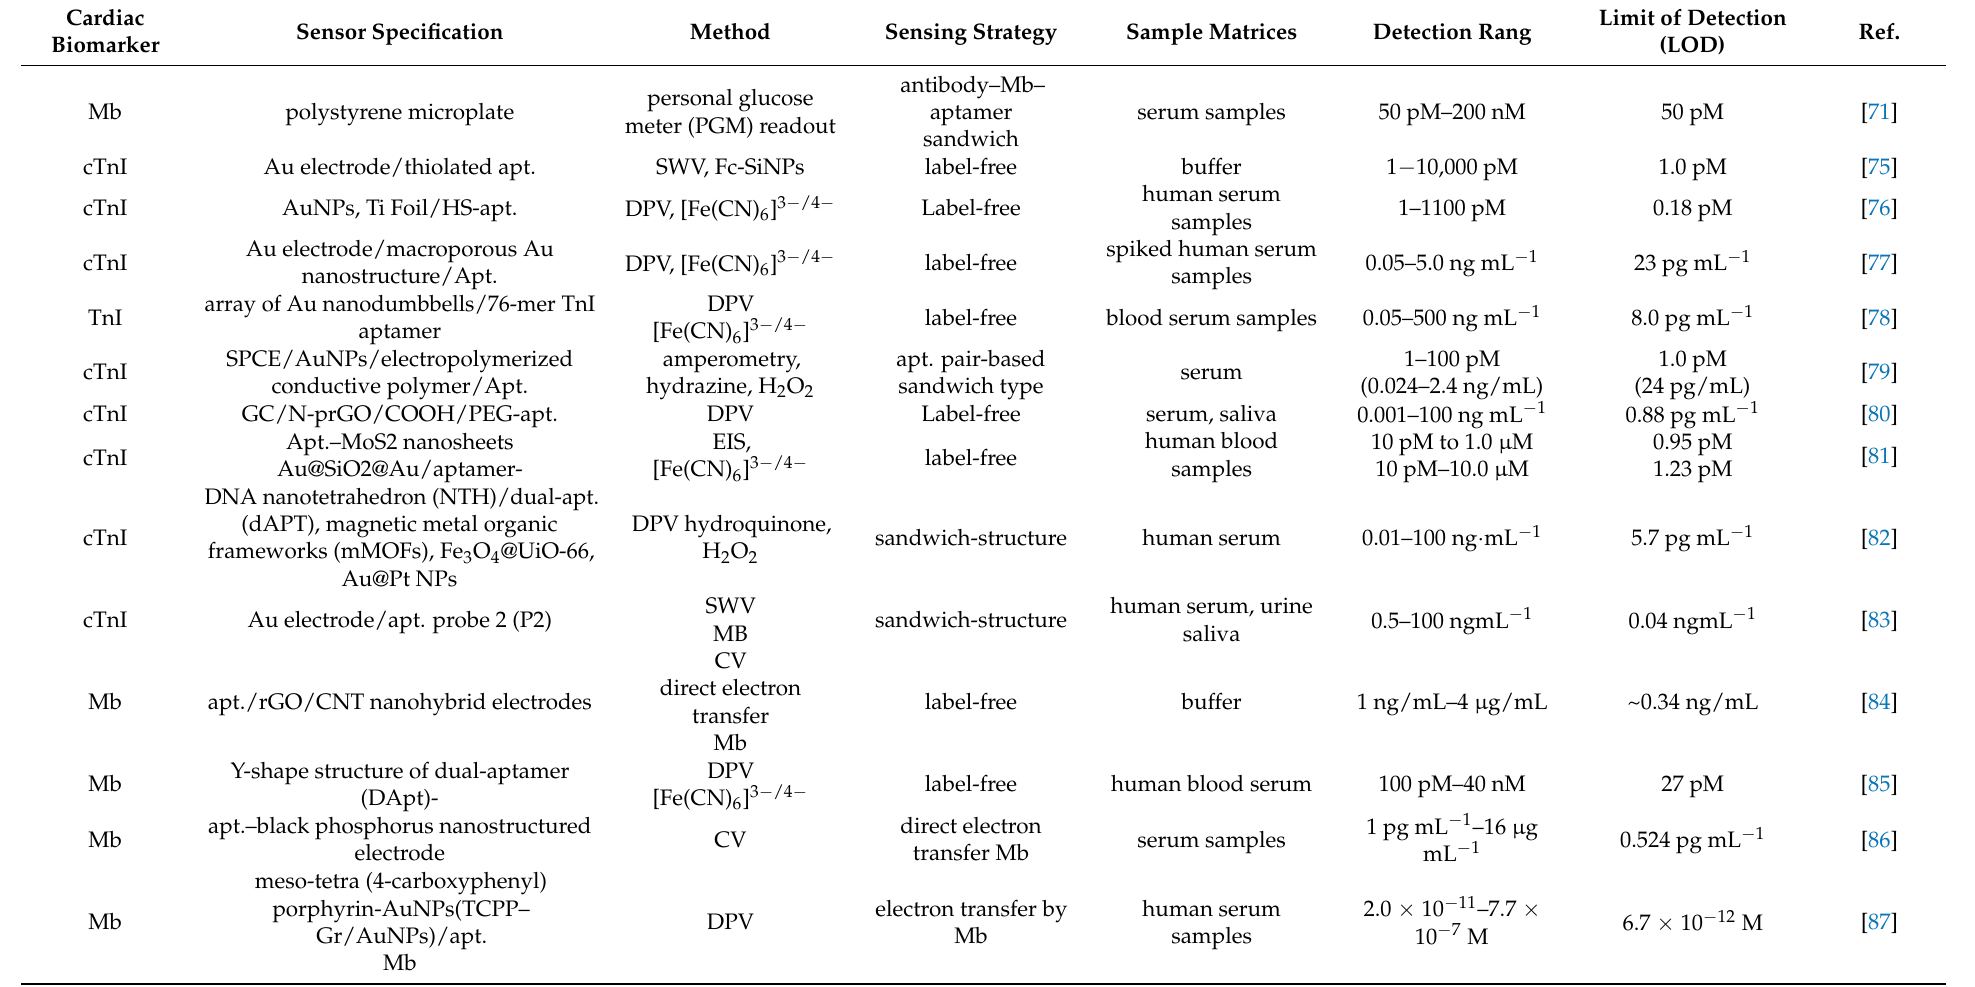
Table 1. Performance and detection methods of different electrochemical cardiac